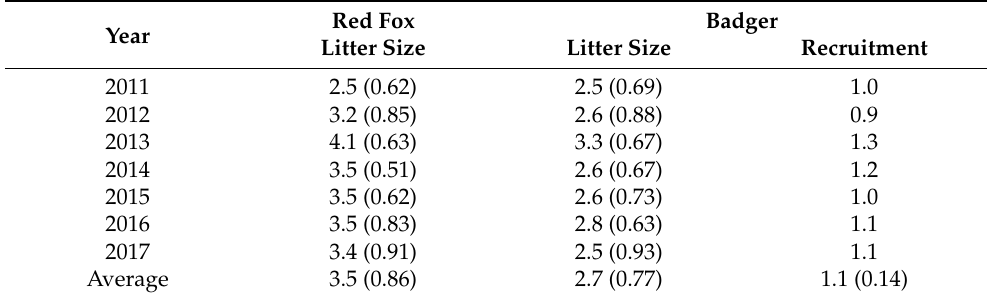
Table 1. Mean ( ± SD) number of red fox and badger cubs per litter and recruitment of badgers (N juveniles/N adults) recorded annually in the study area (field and forest mosaic, Central Poland) in the seven-year study period. Red Fox Badger Year Litter Size Litter Size